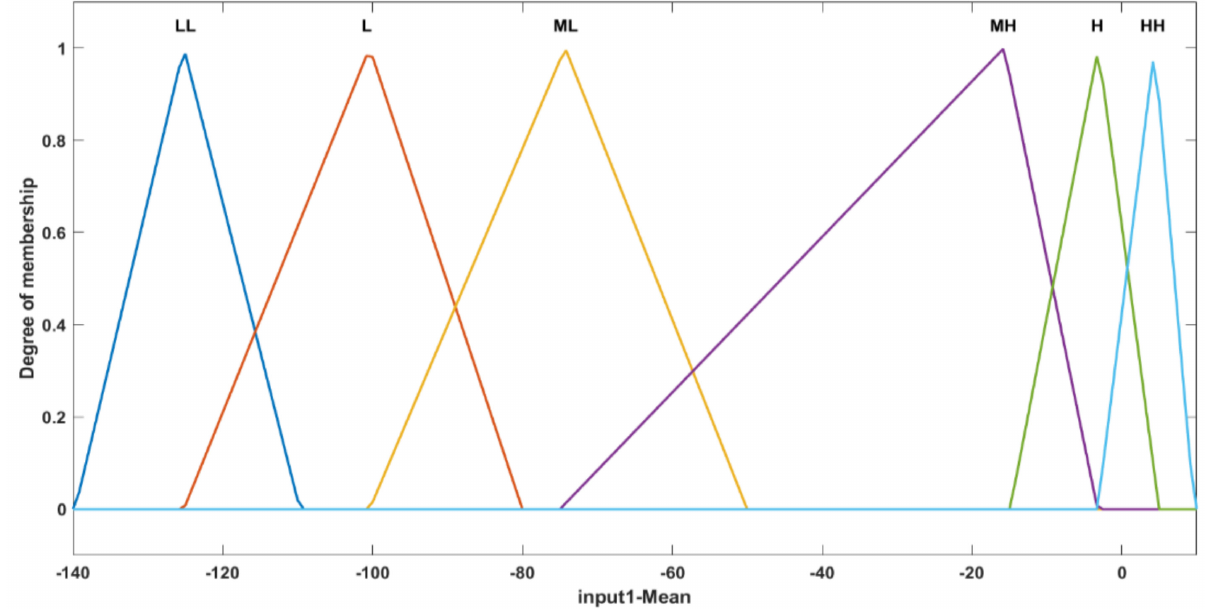
Figure 6. The membership function for input-1 to the fuzzy classifier based on the mean values of frequency